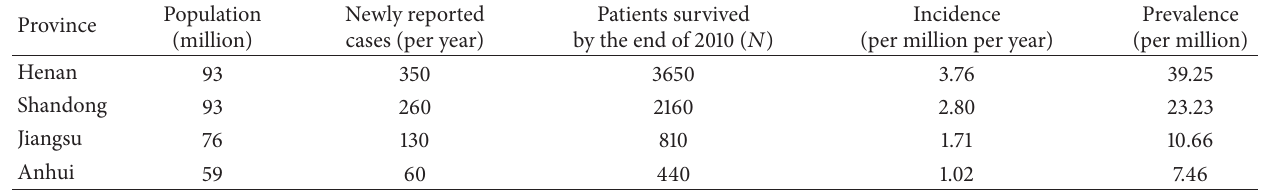
Table 4: Incidence and prevalence of the provinces of Henan, Shandong, Jiangsu, and